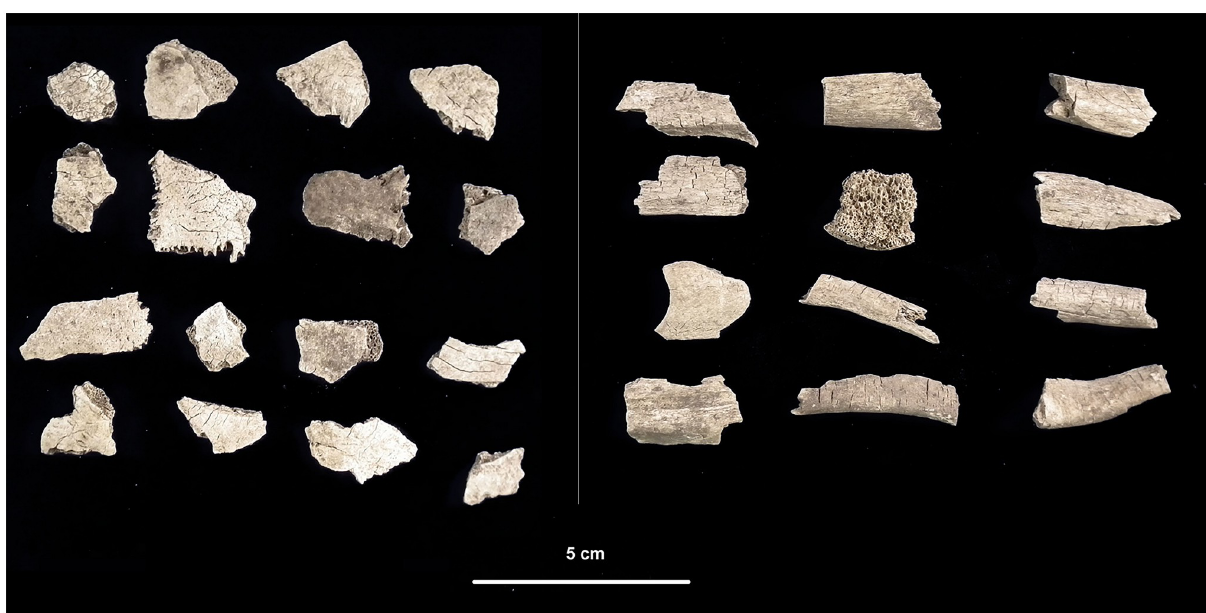
Fig 4. Selection of cranial and long bones’ diaphysis fragments from feature ‘US 11’, showing typical morphological and microstructural modifications due to high temperatures during cremation.